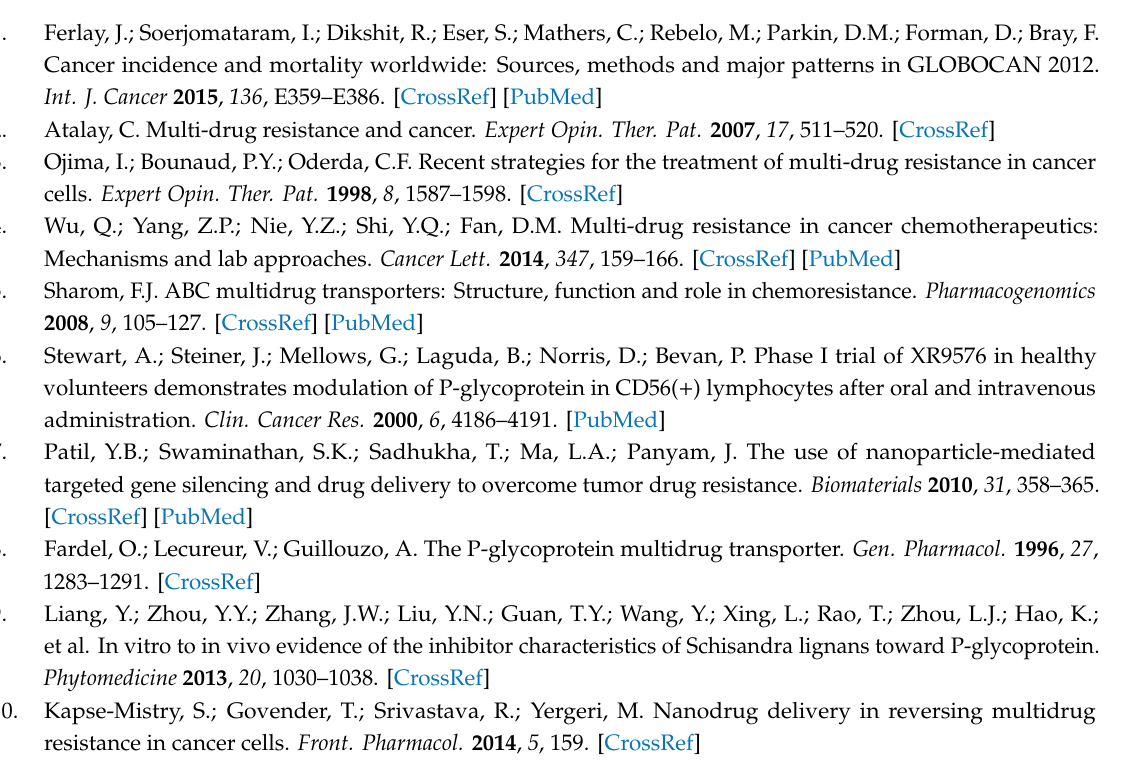
Figure S1: 1 H-NMR spectrum of compound 160a, Figure S2: Chromatograph of compound 160a analyzed by UPLU / MS, Figure S3: The three-dimensional model of compound 160a interacting with P-glycoprotein obtained in Molecular